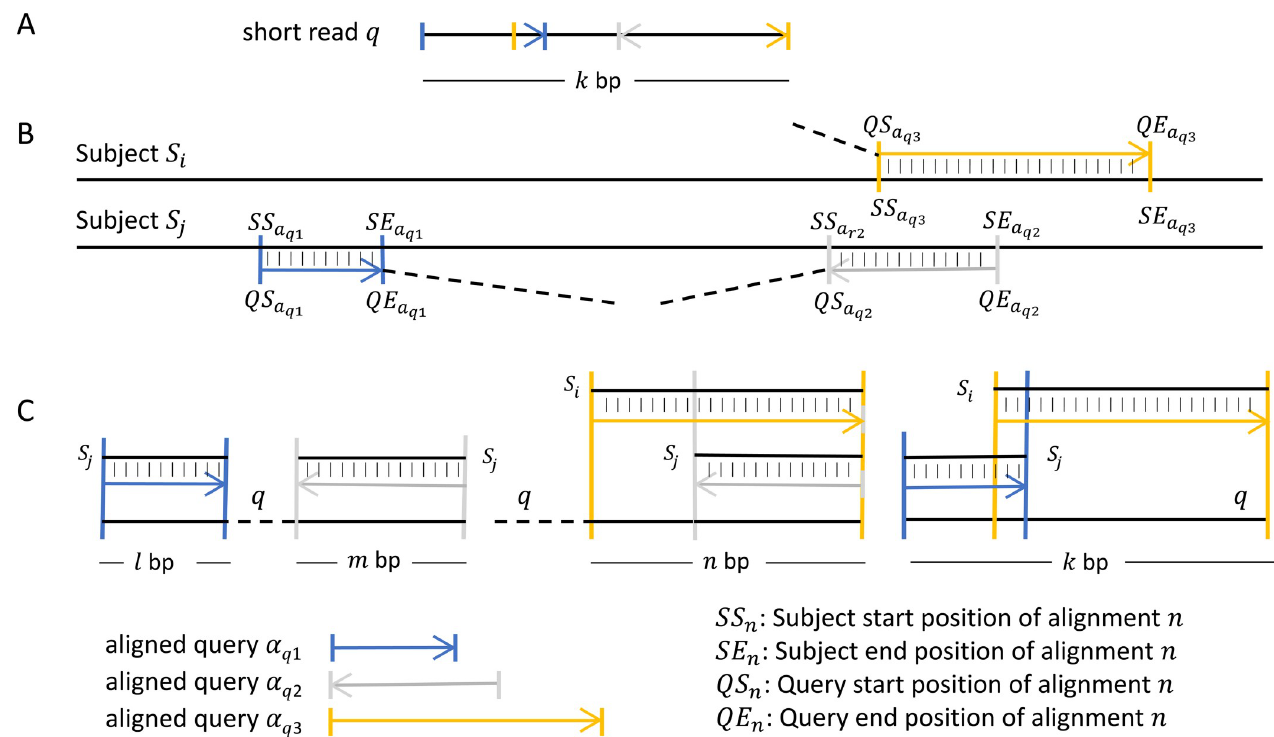
Fig 5. Multiple alignments of the same read. Schematic representation of multiple alignments of one read (A) against more than one reference (B). When examining a pair of such alignments the aligned parts of the read may cover a subset of the read or the total read and, in either case they may or may not overlap